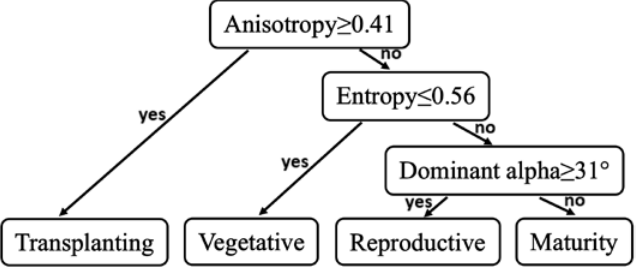
Figure 11. Phenology decision tree. Thresholds of anisotropy, entropy, and dominant alpha angle divide SAR data into four phenological phases.